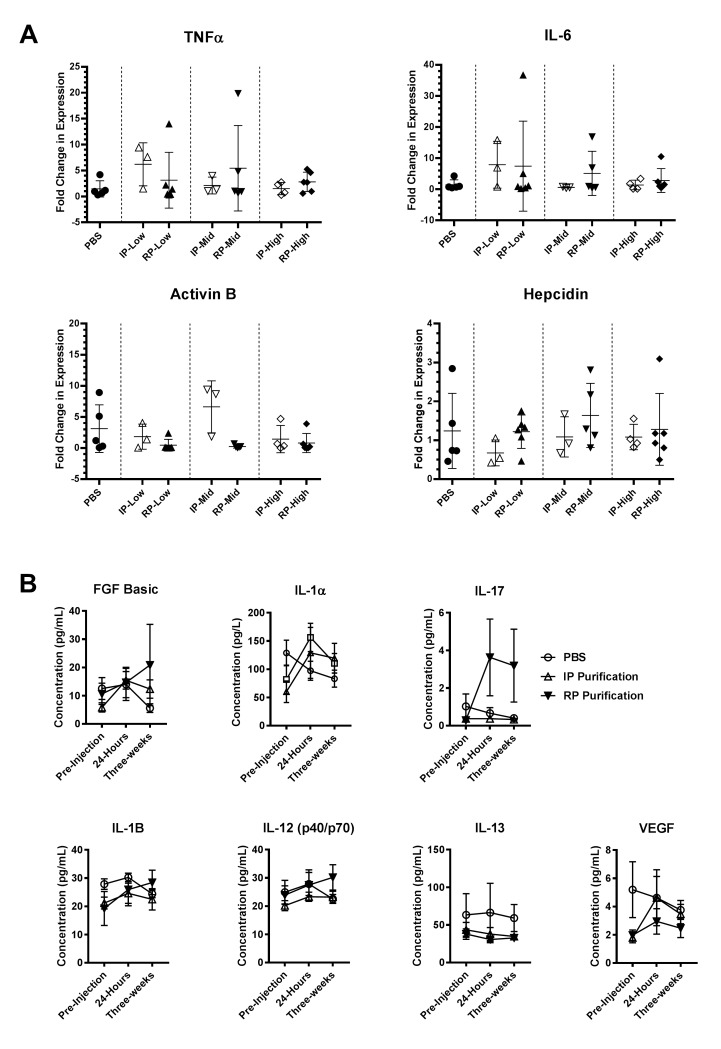
Injection with RP-rAAV8-CMV-eGFP does not induce expression of inflammatory markers in mouse liver or systemic cytokines.129/S mice were injected intraperitoneally with PBS, IP-rAAV8-CMV-eGFP, or RP-rAAV8-CMV-eGFP. (A) Isolated liver RNA was used for quantitative RT-PCR using primers for TNFα, IL-6, Activin B, or Hepcidin. Expression is represented as relative to the PBS data set (β actin-normalized). Data are represented as scatter plot with mean ± S.E.M. bars (n = 3 to 6 mice). One-way ANOVA with Dunnett’s correction did not reveal any significant differences in the means of treatment groups compared to the PBS control group. Indicated doses for rAAV8 vectors are 0.75 x 1011 vg/mouse (Low), 2.25 x 1011 vg/mouse (Mid), or 7.50 x 1011 vg/mouse (High). (B) Serum cytokine concentrations before and after rAAV injection with 7.50 x 1011 vg/mouse were measured by immunoassay. Concentrations units are represented as mean ± S.E.M. (n = 4 mice). Multiple comparison of means using two-way ANOVA with Bonferroni correction did not detect any statistically significant differences between PBS and the treatment groups at each time point. No detectable expression was observed for the cytokines GM-CSF, IFN-γ, IL-2, IL-4, IL-5, IL-6, IL-10, IP-10, KC, MCP-1, MIG, MIP-1α, and TNF-α.